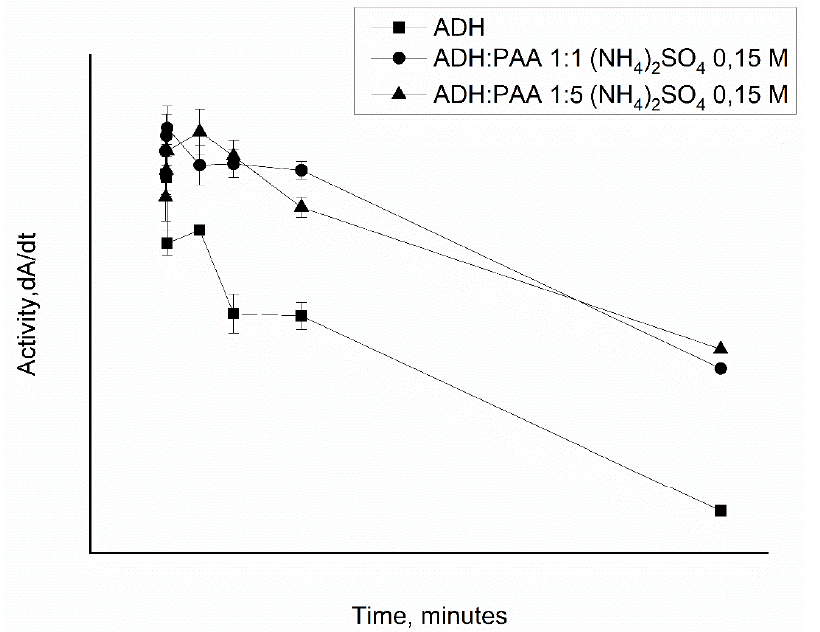
Figure 4. The dependence of the activity of ADH (6.25 μg / ml) in the native state and in the presence of PAA (6.25 μg / ml, 1: 1; 31.25 μg / ml, 1: 5) and ammonium sulfate from the time of incubation.